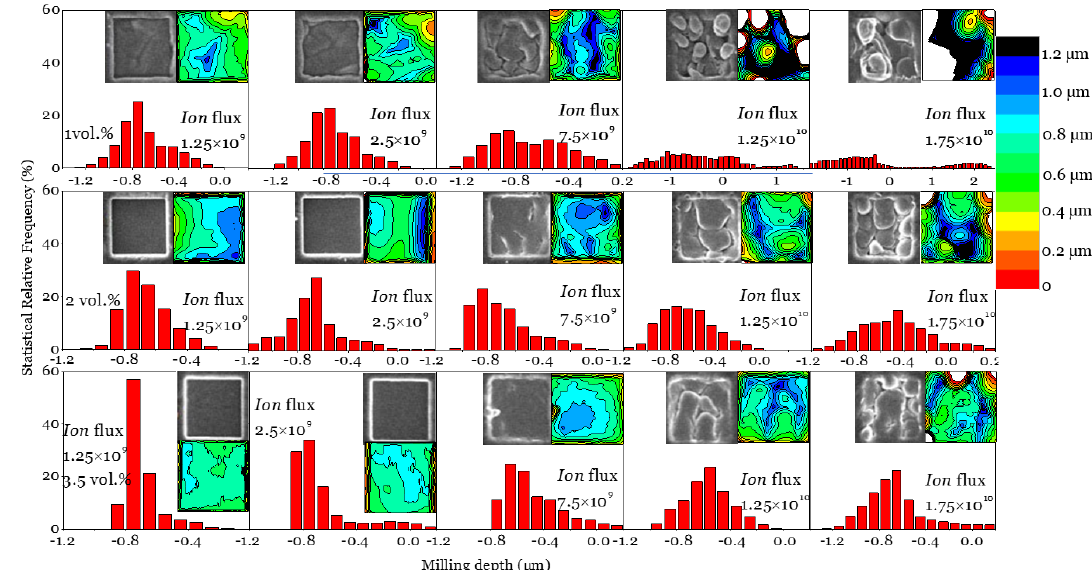
Figure 4. Statistical depth analysis for the milled patterns (5×5 µm 2 , milling time = 160 s) based on AFM results (inset, contour plots) under different ion flux, combined with the SEM images (inset).